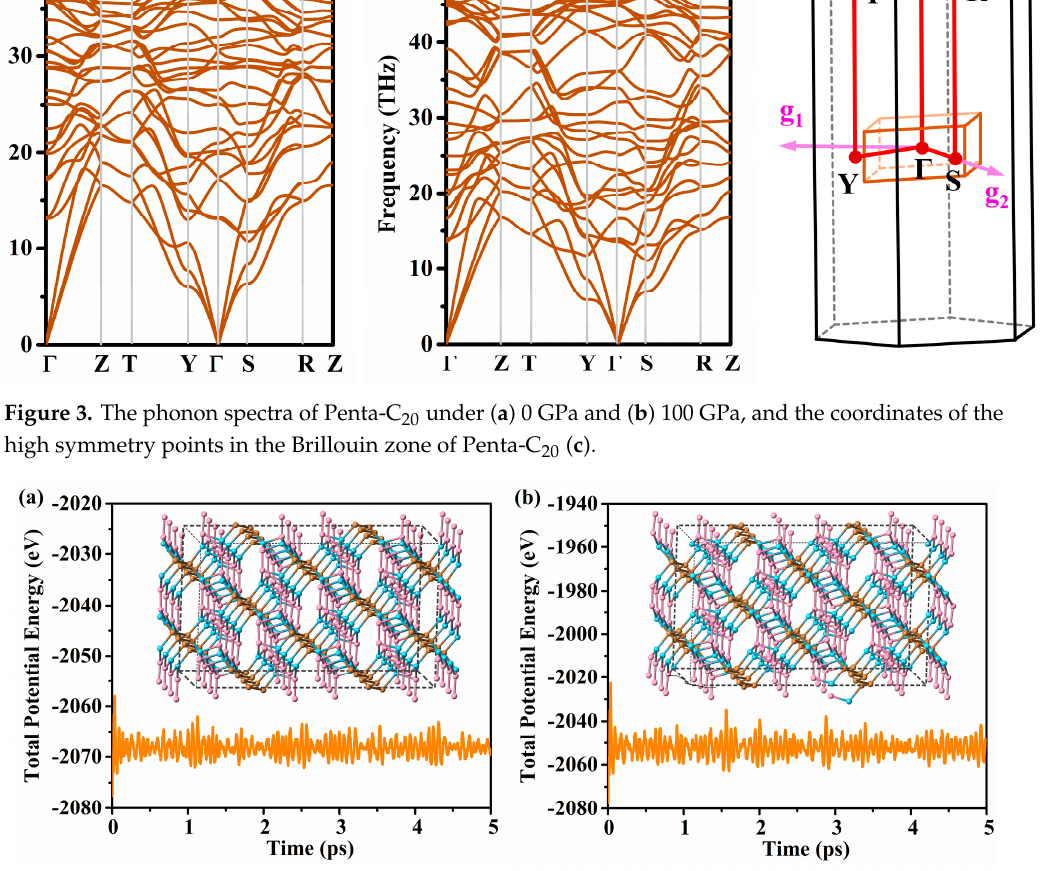
Table 2. The calculated elastic constants (C ij , in GPa), elastic modulus ( B and G , in GPa), and hardness ( H USPEX , H Tian and H Exp , in GPa) for Penta-C 20 and other carbon allotropes. Materials C 11 Penta-C 20